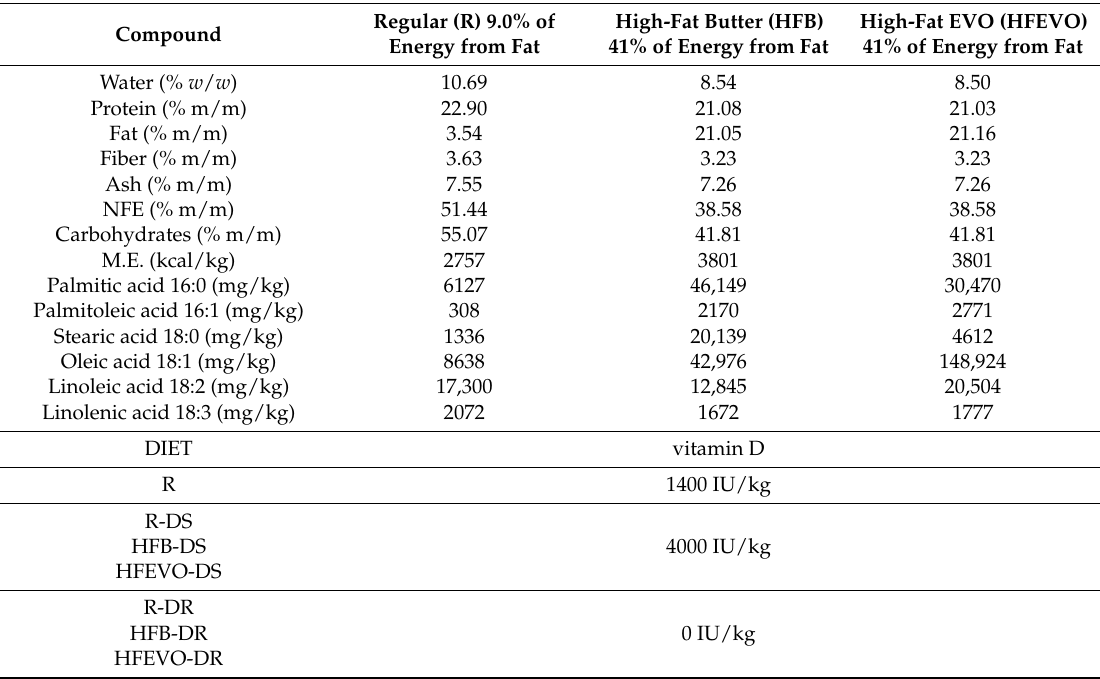
Table 2. Composition of the experimental